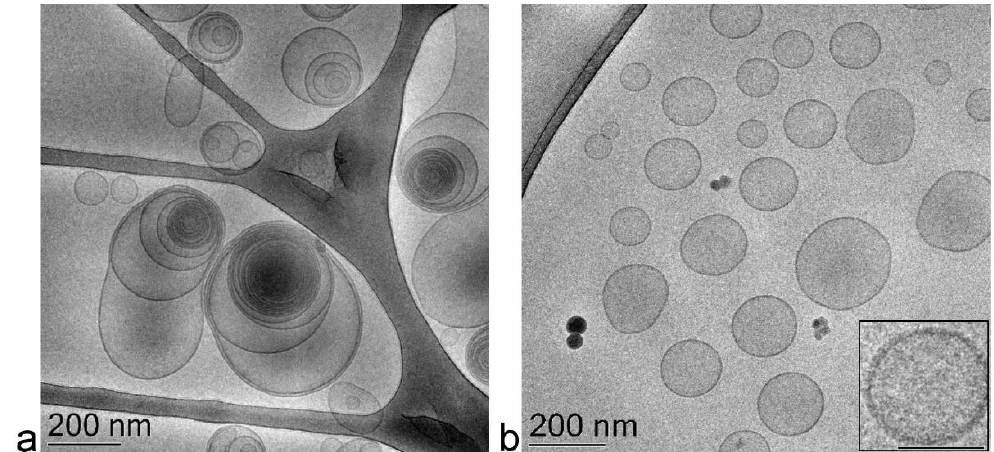
Figure 2. Cryo-TEM images of ET-VD3 ( a ) and TET-VD3 ( b ). The bar corresponds to 200 nm in panels ( a ) and ( b ), 100 nm in the inset of panel ( b ). the inset of panel ( b